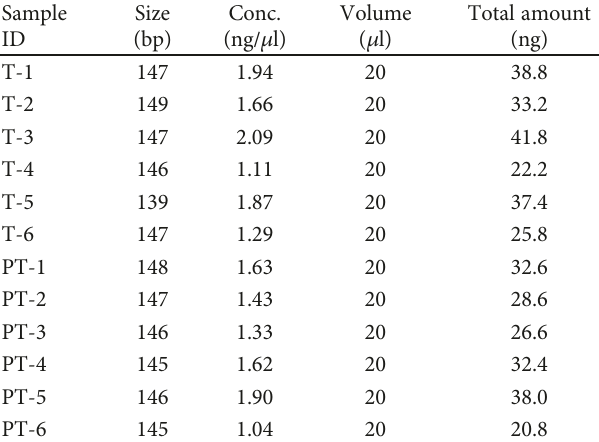
Table 2: Quality assessment of the miR sequencing